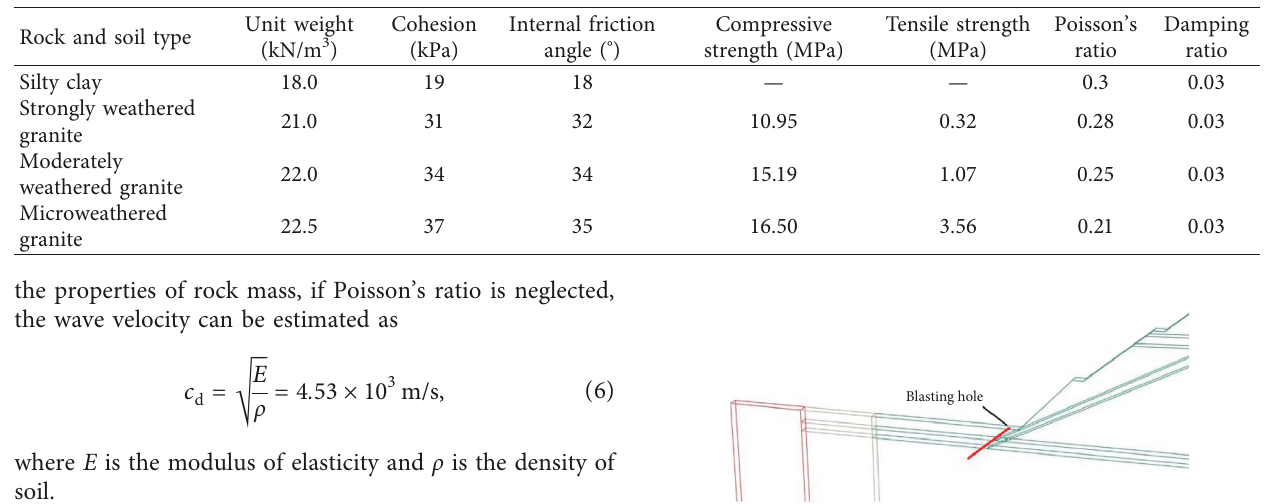
Table 1: Parameters of the rock-soil model.